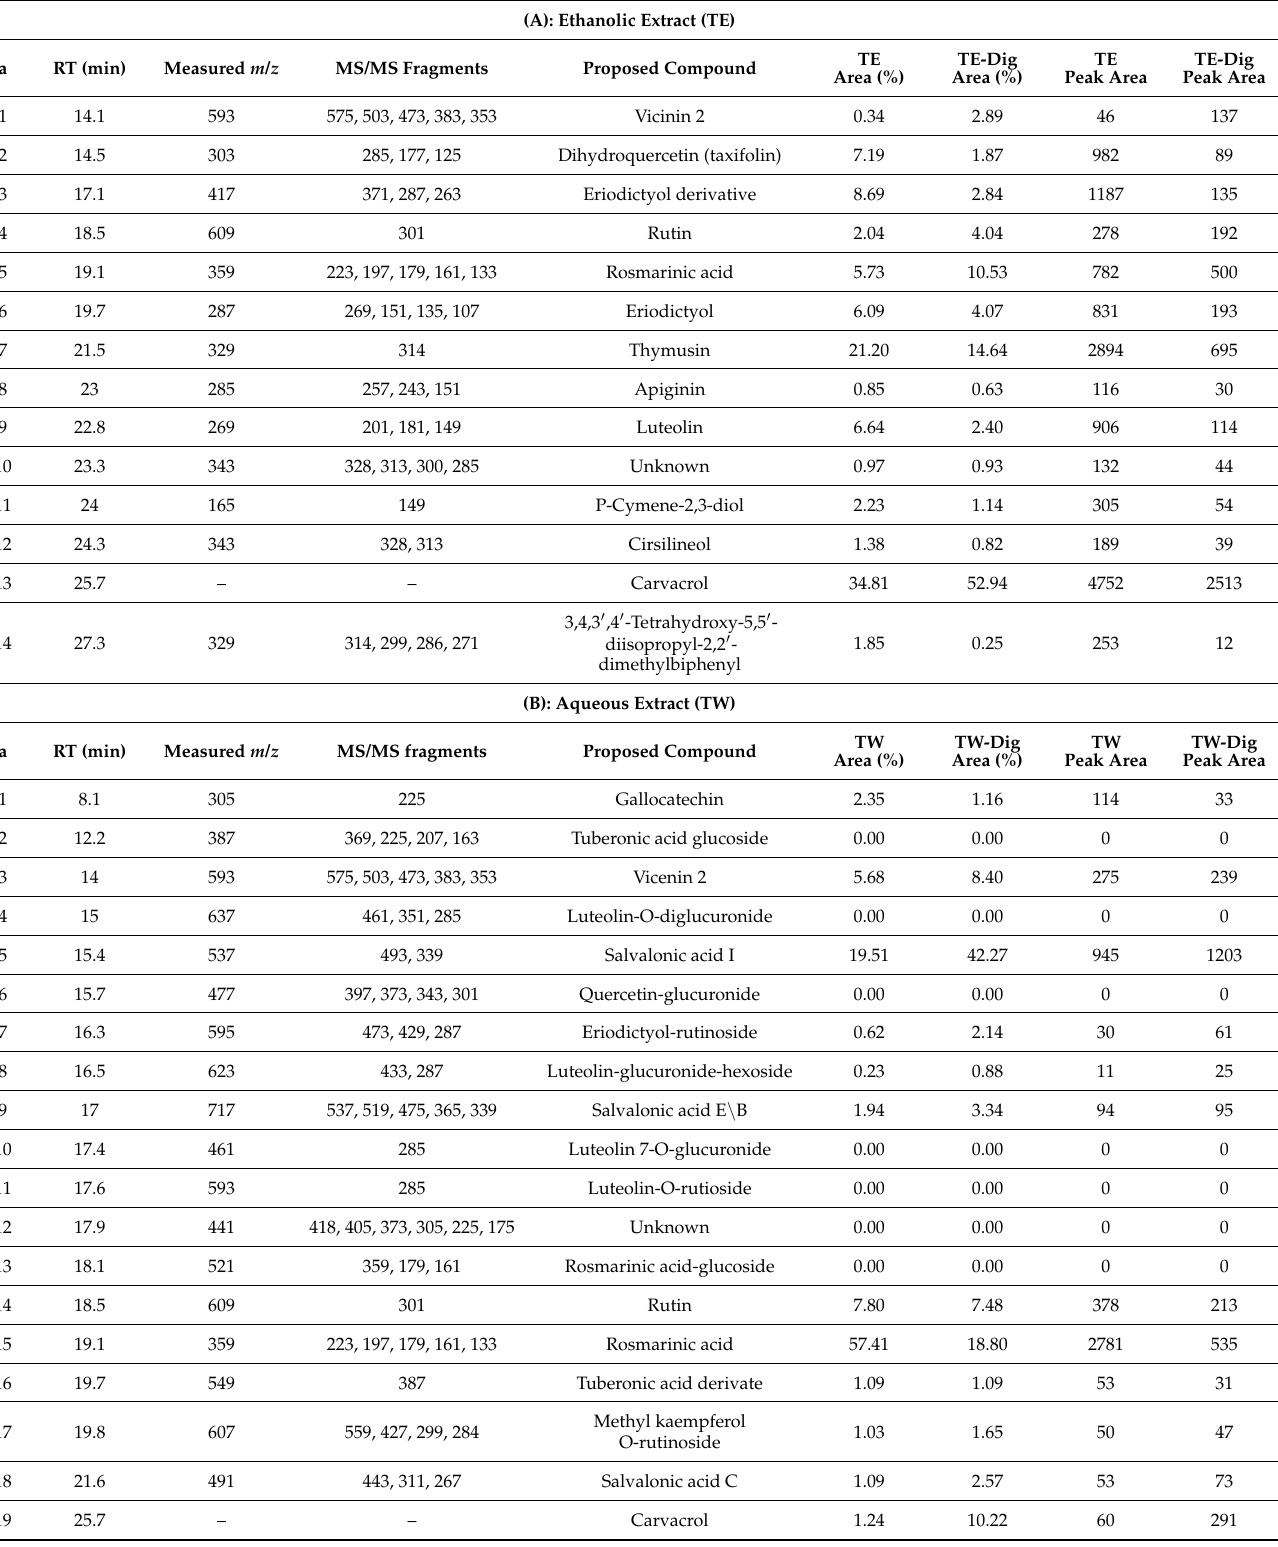
Table 2. Phenolic compounds identified in TE (A) and TW (B) before and after digestion using HPLC–MS/MS in the negative ionization